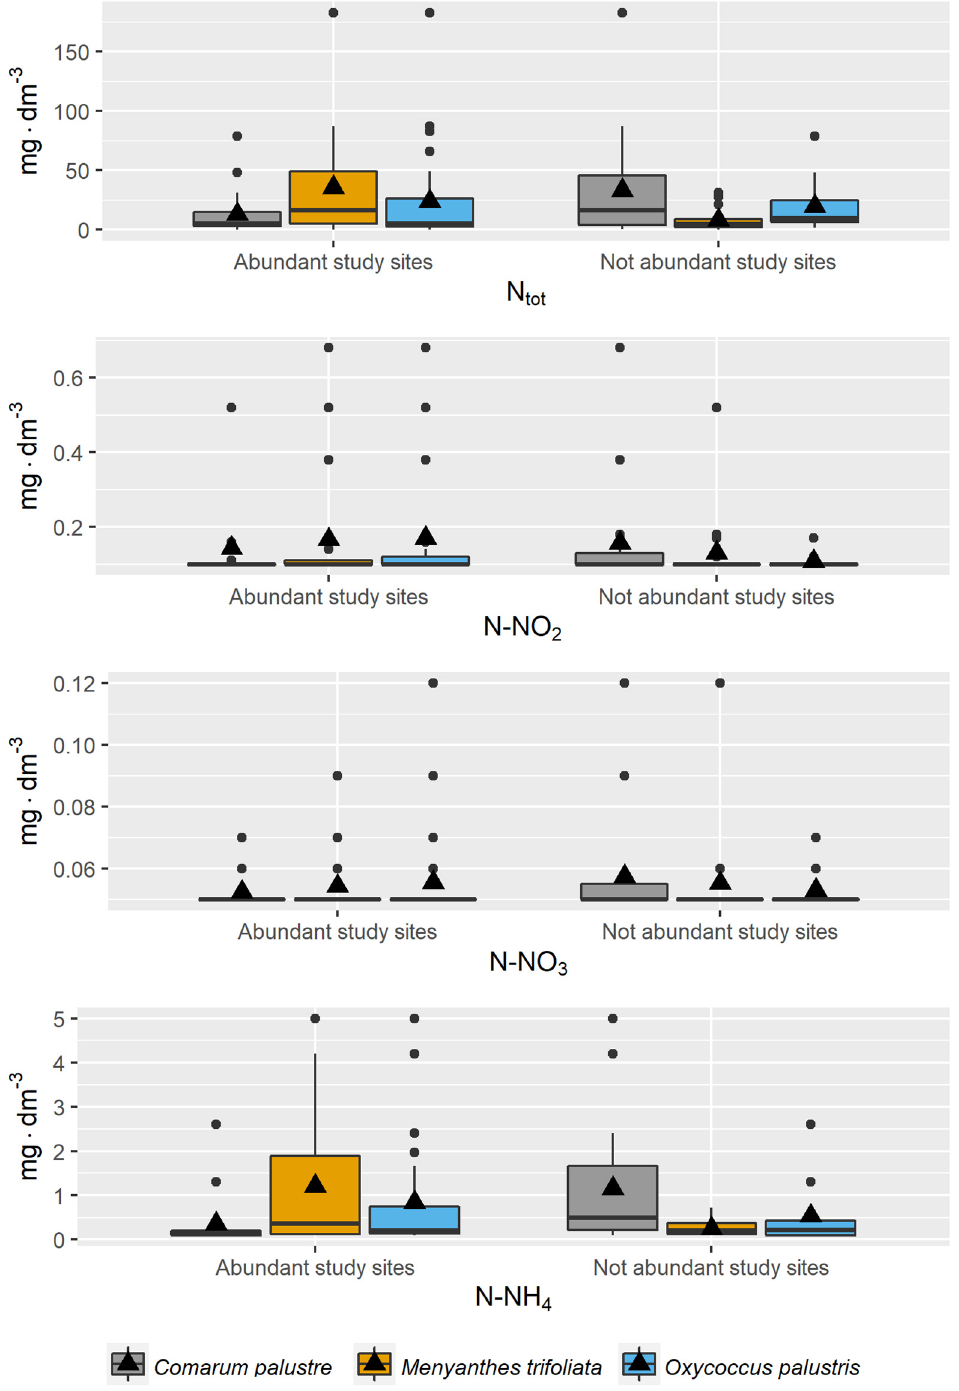
Figure 3. Distribution of values of nitrogen fractions in piezometric groundwater at the study sites for the study species in 2011–2013 (criterion of abundance in habitats). The horizontal line across the central region of the box represents the median. The mean value of the data is marked by a filled triangle. The whiskers are drawn to the most extreme observations. Any observation not included between the whiskers is plotted as an outlier with a filled dot.